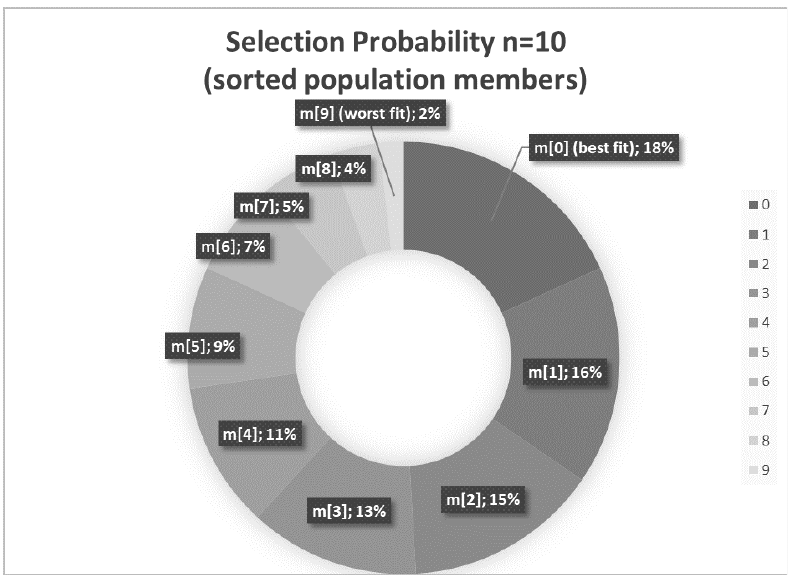
Figure 4. Roulette type selection for sorted population members by fitness (n = 10)